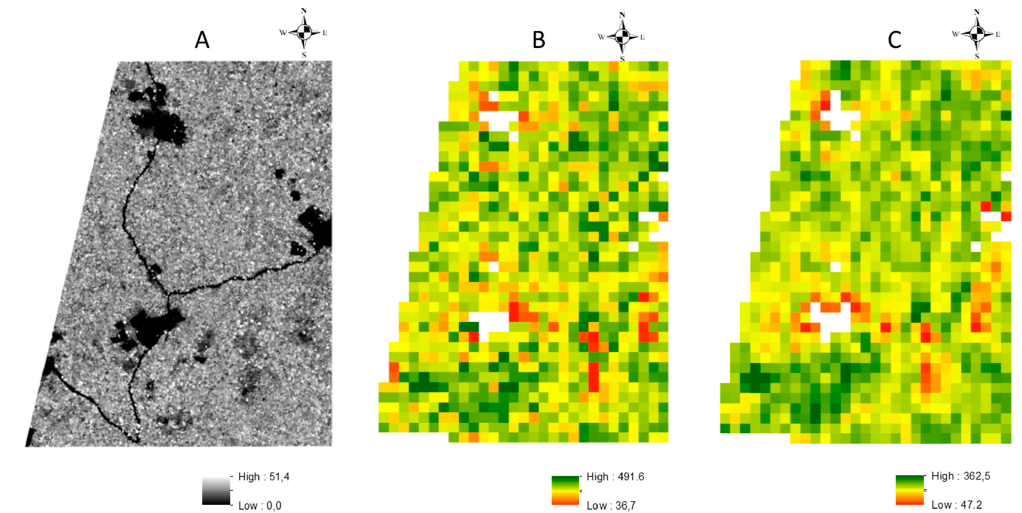
Figure 7. ( A ) Canopy height model (CHM) at 1 × 1 m resolution, showing forest canopy gaps and anthropogenic features, including roads, crops, pastures, and secondary forests, and aboveground biomass (AGB; Mg ha − 1 ) estimates from the ( B ) aircraft and ( C ) GatorEye predictive equations, at a 100 × 100 m plot-scale resolution. Blank cells in the AGB models are non-forest areas. All maps are based on the aircraft-derived LiDAR data acquired in 2015. Remote Sens. 2020 , 12 , x FOR PEER REVIEW